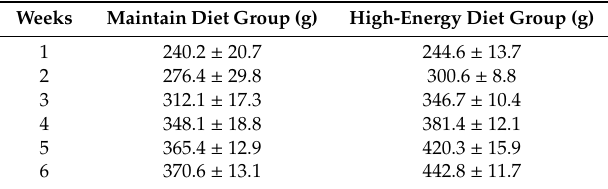
Table 1. Body weight changes during model establishment.